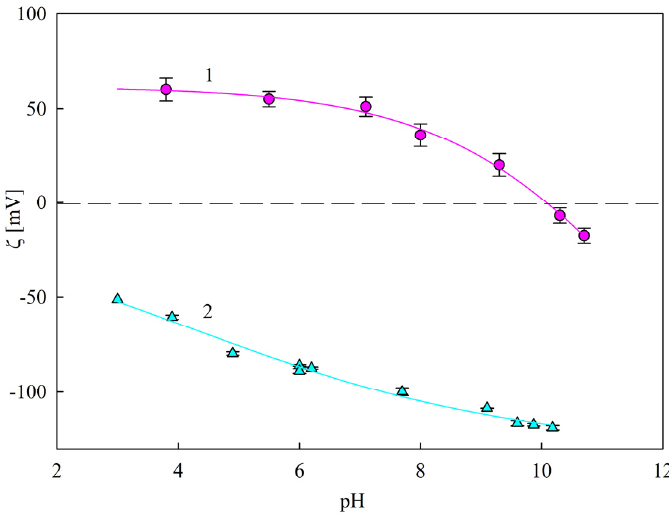
Figure 4. Dependence of the zeta potential of mica on pH, determined by the streaming potential method. 1—( ● ) mica/PAH [25]; 2—( ▲ ) bare mica, 1 mM NaCl. The solid lines represent fits of experimental data.